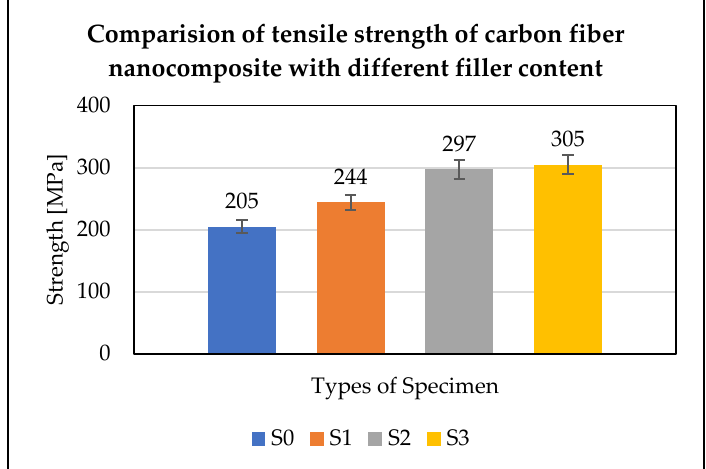
Figure 5. Tensile strength. Table 10. Results of tensile tests.